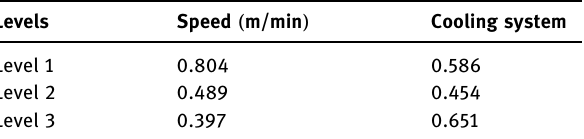
Table 7: Grey relational degrees of the factor levels for